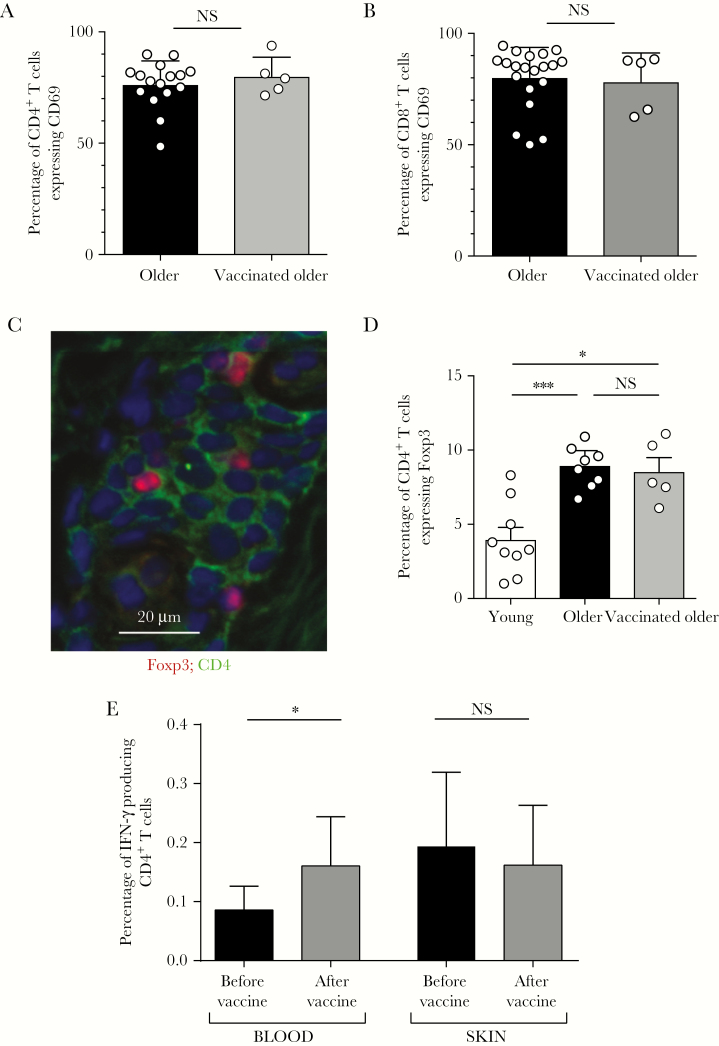
Zostavax vaccination leads to an increase in circulating but not skin-resident varicella zoster virus (VZV)–specific T cells. Punch biopsy specimens (diameter, 5 mm) were taken from unchallenged skin before and after vaccination and immunohistological assessment was performed. A and B, Frequency of CD4+ (A) and CD8+ (B) T cells that expressed CD69. C and D, Representative immunostaining of CD4 (green) and Foxp3 (red; C) and cumulative data showing the frequency of Foxp3+ CD4+ T cells (D) in young and older individuals (before and after vaccination). E, Peripheral blood and skin-derived VZV-specific CD4+ T cells were enumerated by intracellular cytokine staining following overnight stimulation with VZV lysate (n = 6 for skin and n = 10 for blood). For panels A and B, data were assessed by the Mann-Whitney test. For panel D, data were assessed by 1-way analysis of variance with the Tukey post hoc test. For panel E, data were analyzed by the Wilcoxon paired test. Abbreviation: NS, not significant. *P < .05 and **P < .01.